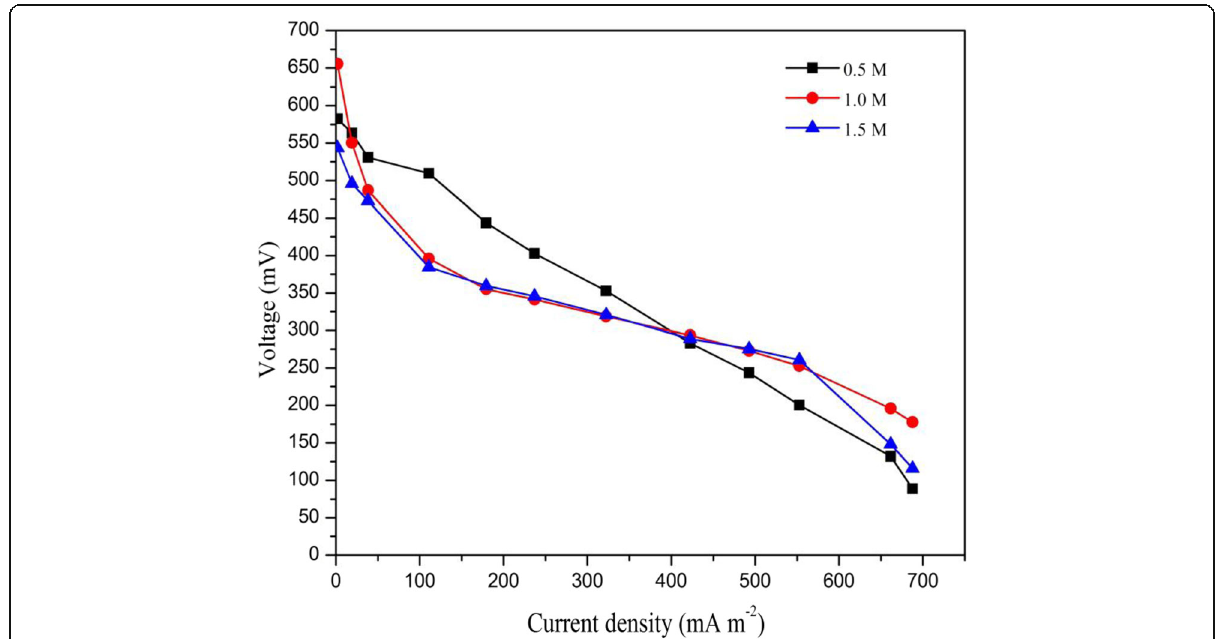
Fig. 5 Polarization curve for different concentrations of pottasium ferricyanide catholyte